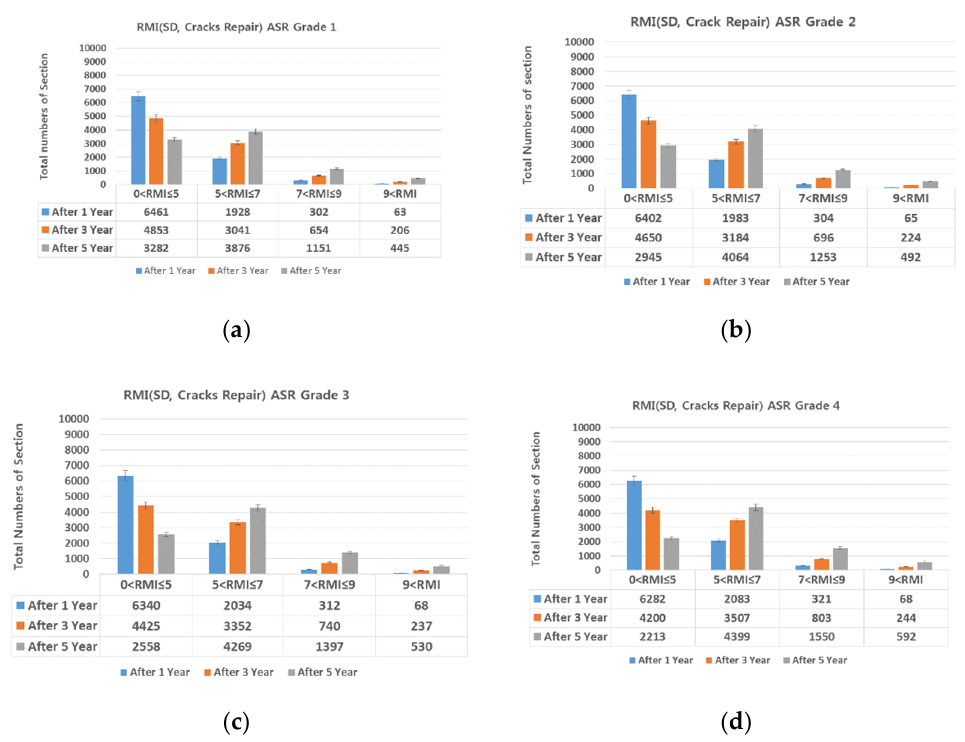
Figure 17. ( a ) crack repair and ASR grade 1; ( b ) crack repair and ASR grade 2; ( c ) crack repair and ASR grade 3; and ( d ) crack repair and ASR grade 4.